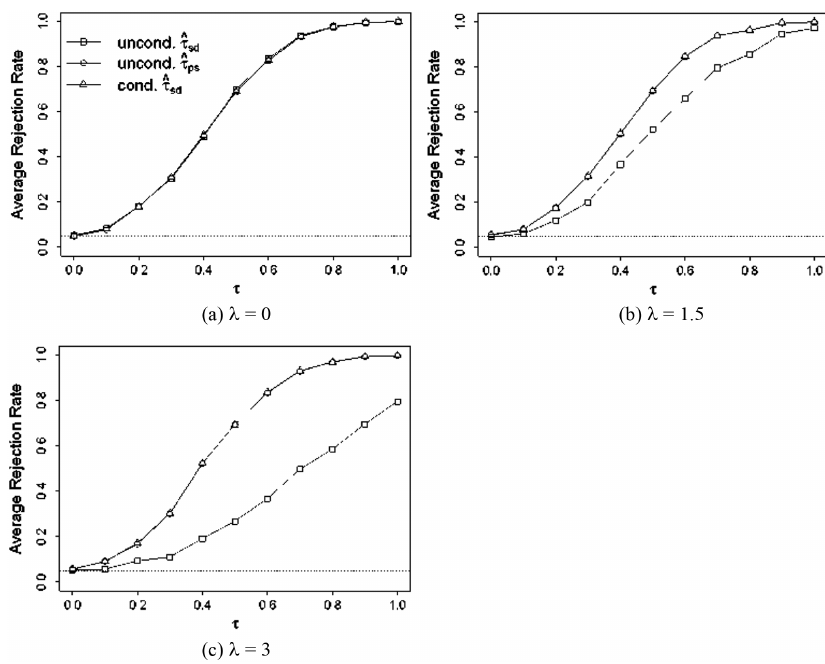
Figure 2: Unconditional average rejection rates for different τ and λ